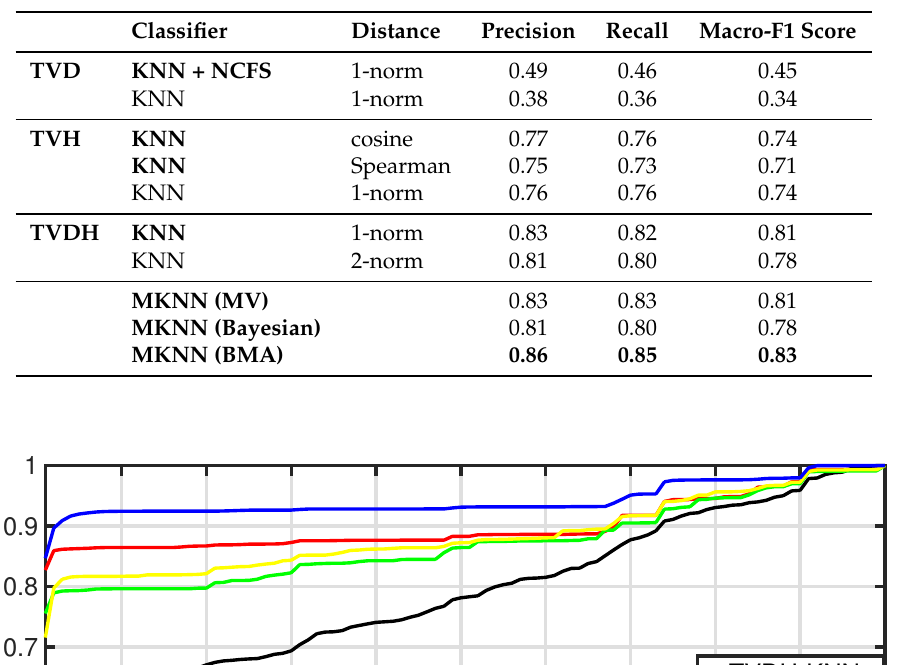
Table 1. Classification results for single K-NN and Multiple K-Nearest Neighbor (MKNN) algorithms. BMA, Bayesian Model Averaging.